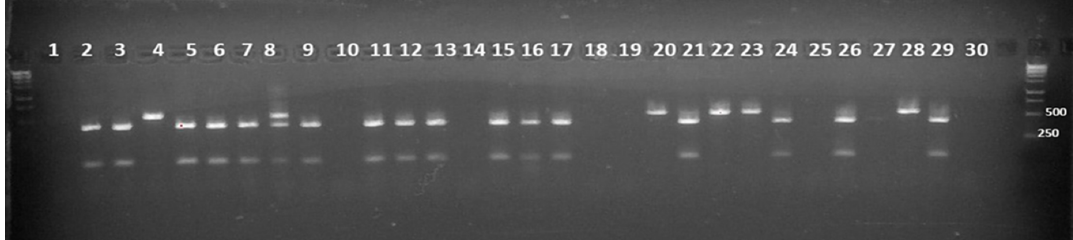
Figure 3. PCR amplification of the selected plants and parent lines with Pto marker for resistance towards Pseudomonas syringae pv. Tomato . Lanes 1–22: selected plants; lanes 23–30: parental lines; 1 Kb ladder.